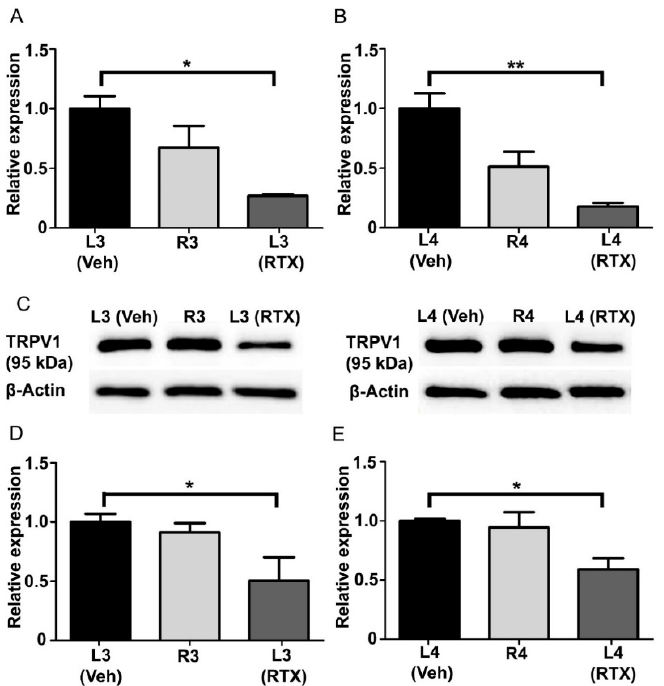
Figure 8. The level of TRPV1 mRNA and protein expression in left L3 and L4 DRGs after 14 days of intraplantar injection of RTX/vehicle in the left hind paw. A significant decrease in TRPV1 mRNA ( A , B ) and protein ( C – E ) expression was observed in the left L3 and L4 DRGs ipsilaterally injected with RTX compared to vehicle-injected or contralateral right control L3 and L4 DRGs. [* p < 0.05; ** p < 0.01, * vehicle vs. RTX-injected groups ( n = 3–5 per group)].